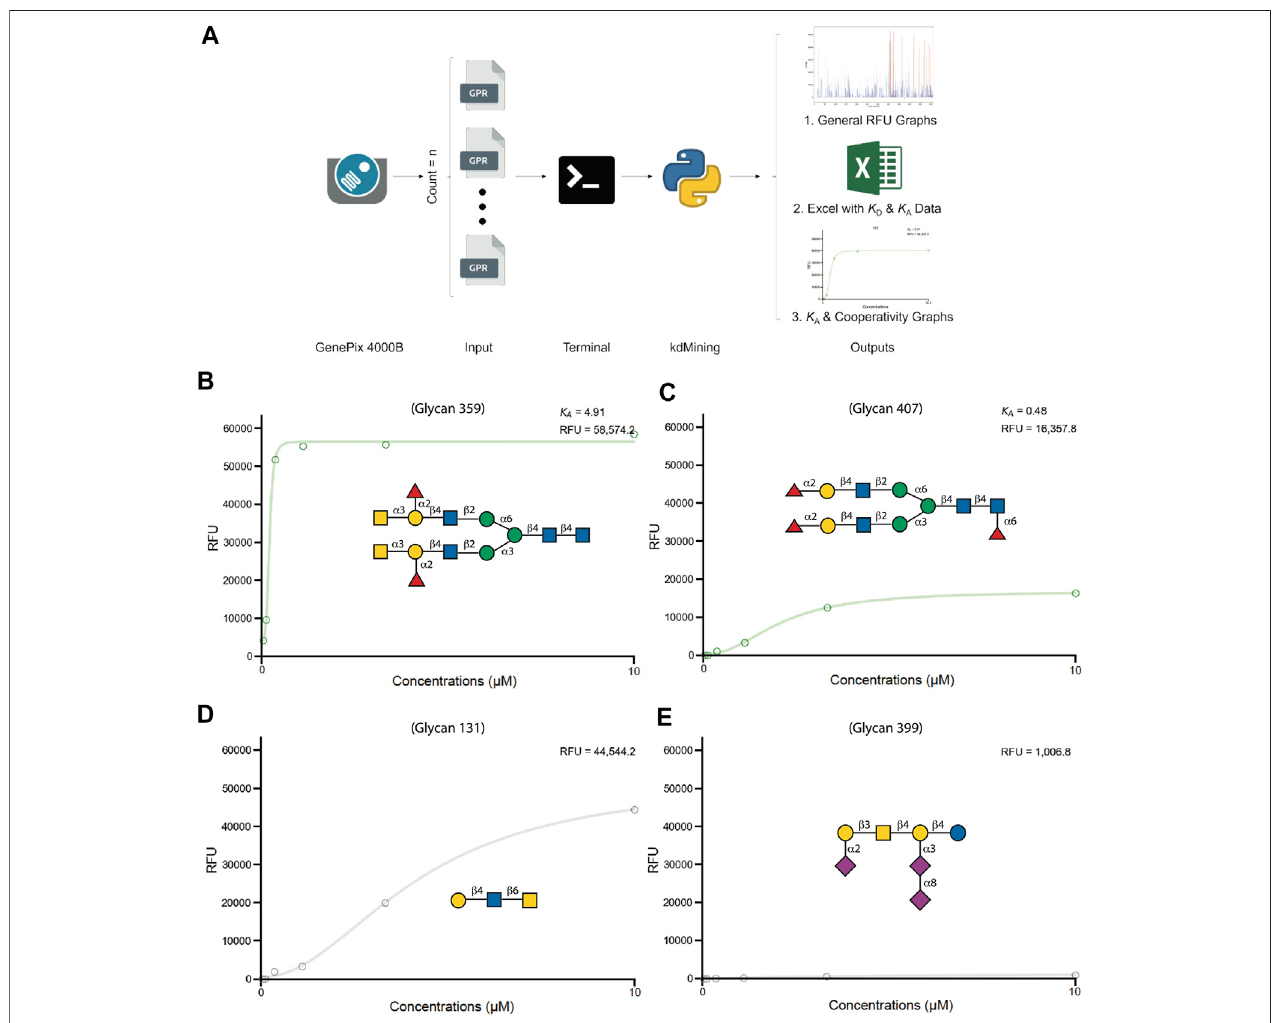
FIGURE 2 | kdMining analysis for determining GBP-glycan binding af fi nity . (A) Overview of kdMining program. Once kdMining is executed in the machine ’ s terminal, all raw RFU gpr fi le inputs in the designated folder are processed automatically. Three types of output are generated: bar chart of RFU values for each protein concentration, Excel fi le of calculated K D and K A , and fi tted dose response curves for all glycan samples. (B – E) Demonstration of kdMining ’ s fi tting graphs for hGal-9 binding at indicated concentrations (10uM, 3.3µM, 1.1µM, 0.36µM, 0.12µM, 0.04 µM). The fi tted dose response curves for CFG glycan number 359 (B) , CFG glycan number 407 (C) , CFG glycan number 131 (D) , CFG glycan number 399 (E) . The calculated K A and RFU value are shown on the upper right. The green and gray fi tted lines represent saturated and unsaturated samples,